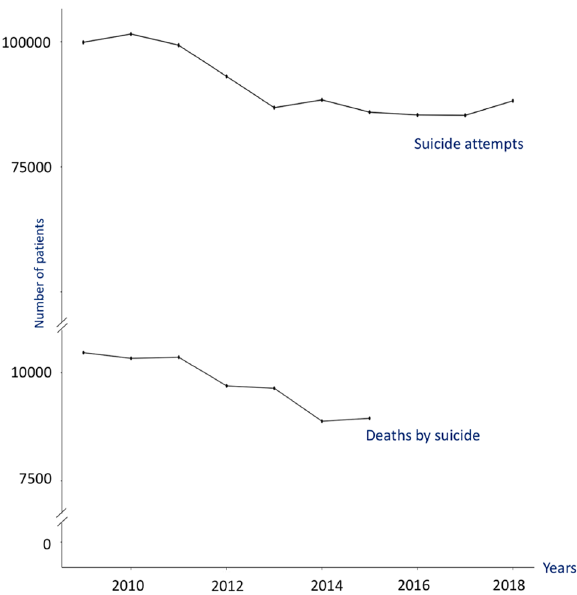
Figure 3. Evolution of death by suicide and suicide attempts over the years